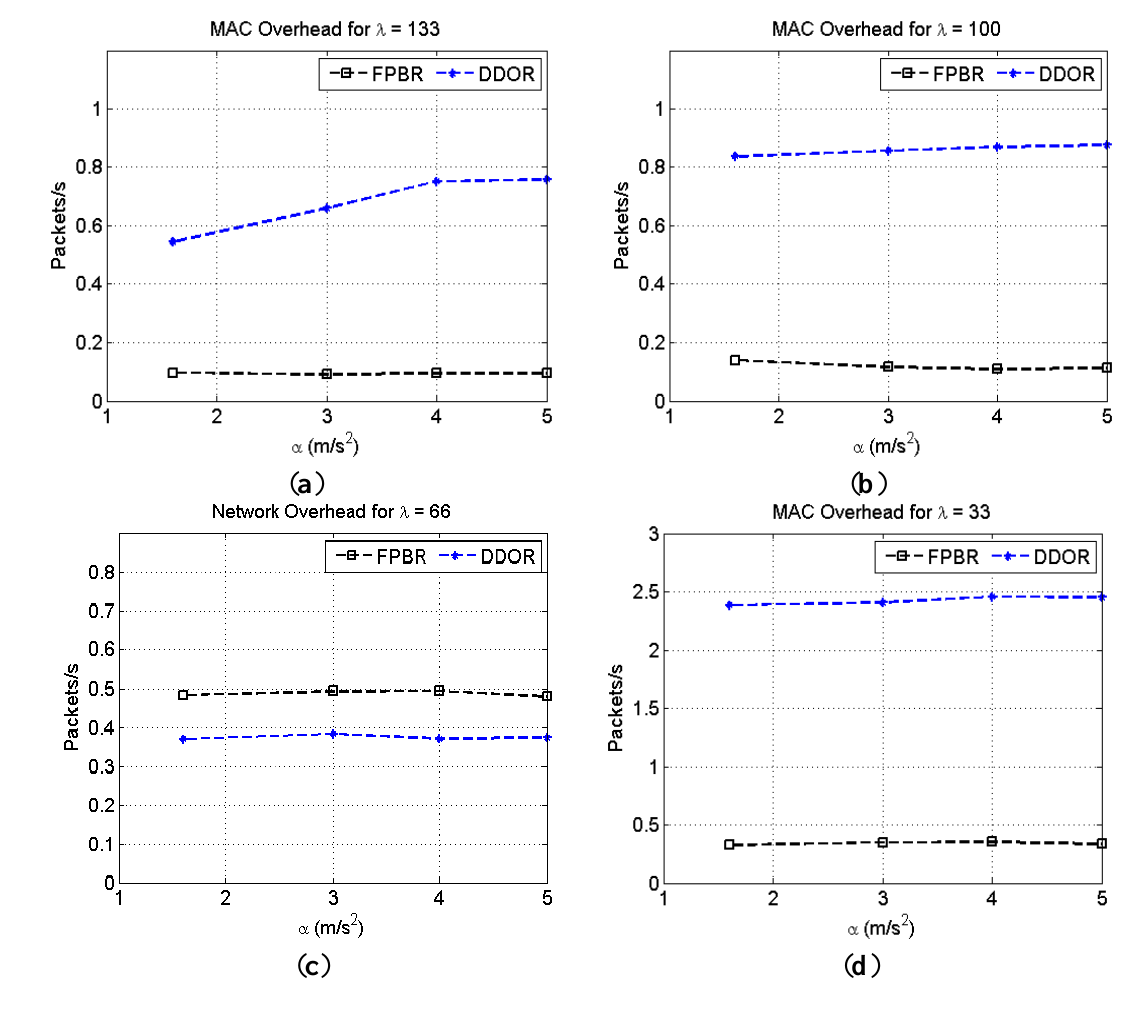
Figure 16. Normalized MAC overhead obtained with FPBR and DDOR when increasing the maximum acceleration, . Four different vehicle densities, , were considered for these plots. Each plot shows the MAC overhead vs. α for: ( a ) λ = 133; ( b ) λ = 100; ( c ) λ = 66 and ( d ) λ =